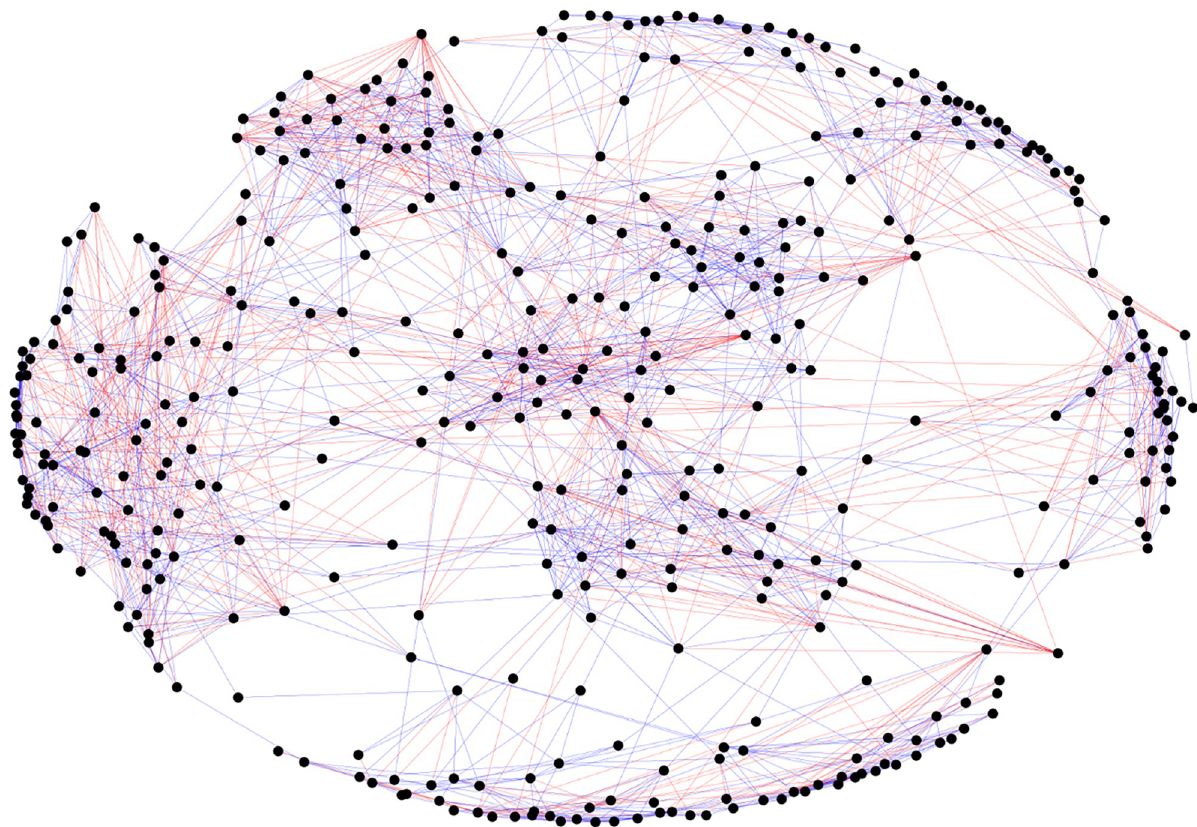
Fig 5. esIZ elementary school signed network. This network has 417 students and 1995 relationships, of which 29.6% are enmity. Each student has on average 6.7 and 2.8 friendship and enmity relationships, respectively.